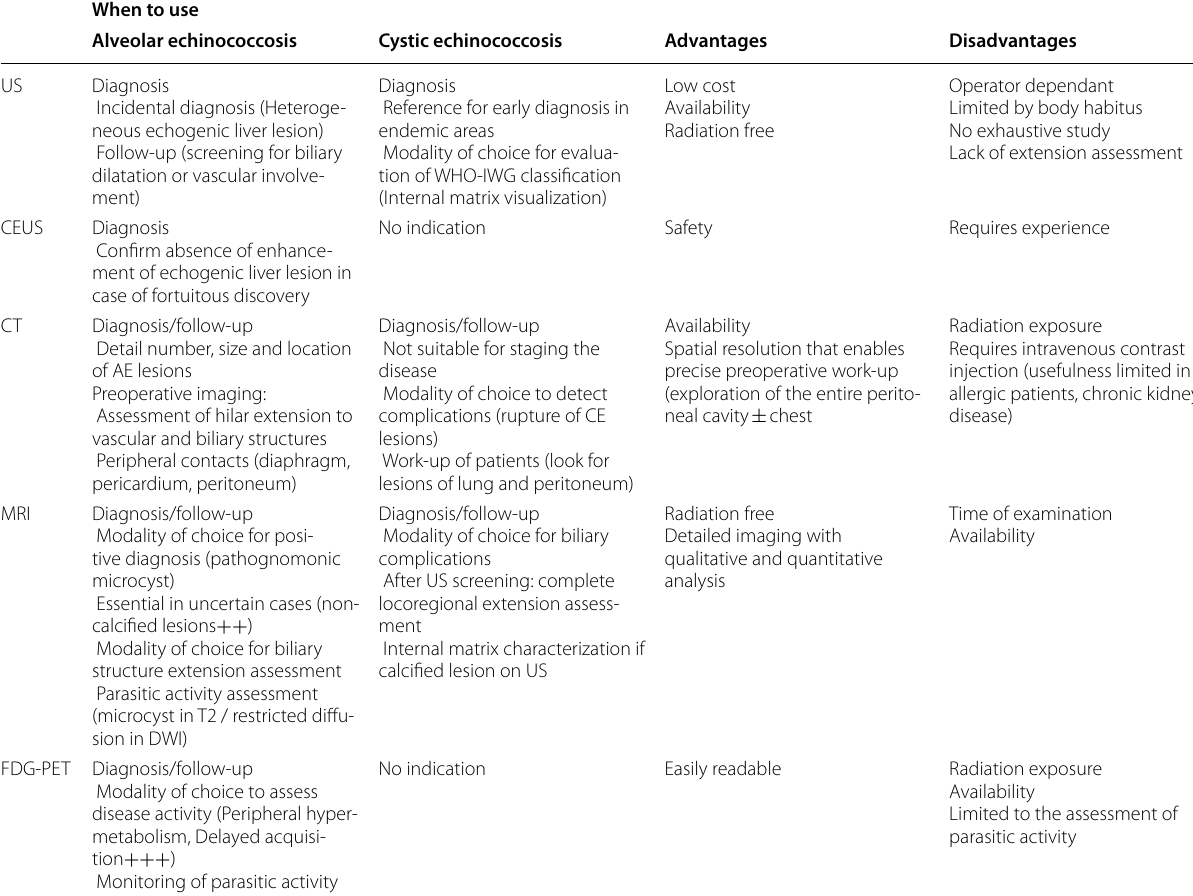
Table 1 Imaging modalities, indications, advantages and disadvantages in AE and CE When to